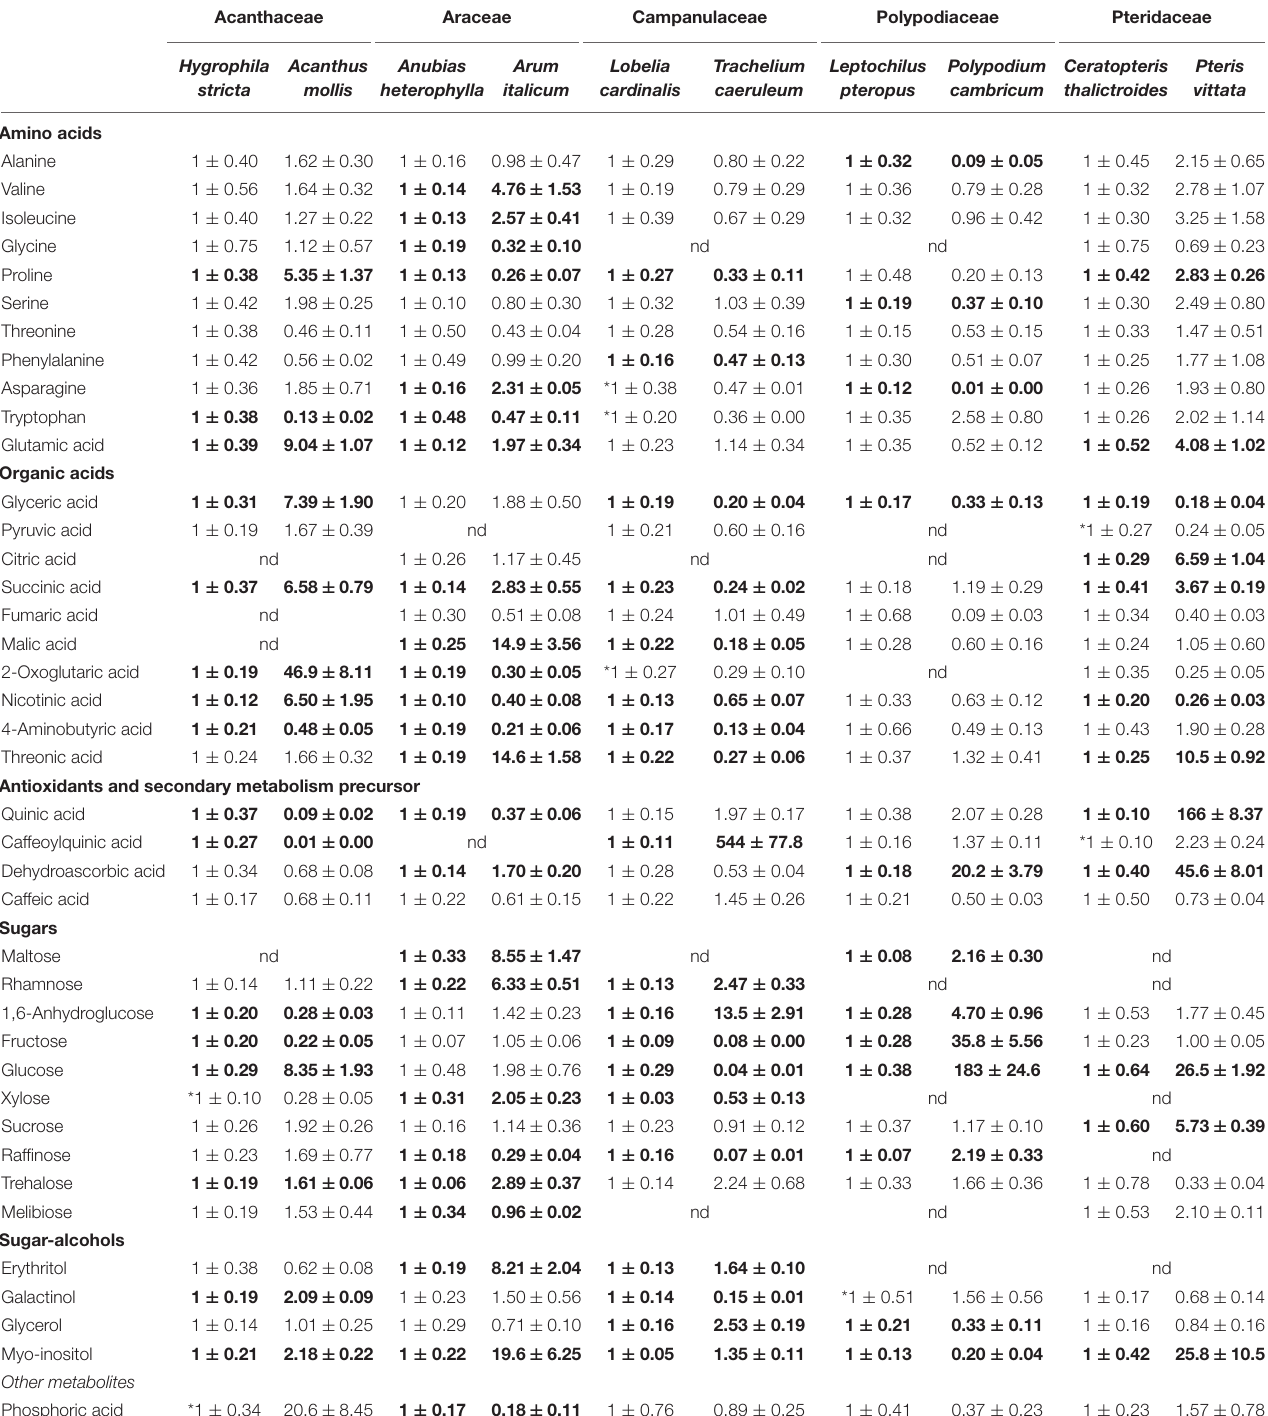
TABLE 5 | Relative metabolite levels in leaves of 10 terrestrial and palustrine plant species belonging to five families of ferns and angiosperms as measured by GC-MS (see section “Materials and